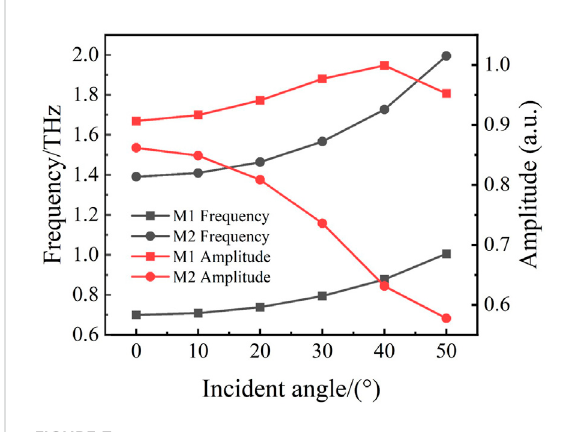
FIGURE 7 ALinegraphofmaximumabsorptionandresonantfrequency of the absorption corresponding to incident angle from 0 ° to 50 °